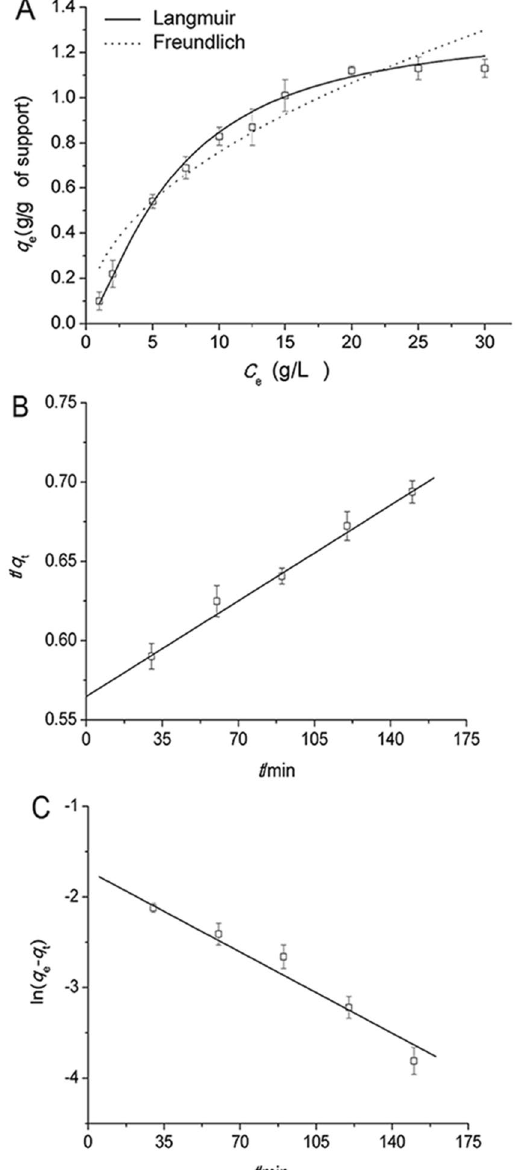
Figure 4. Langmuir and Freundlich isotherms ( A ), pseudo-second-order ( B ) and pseudo-first-order ( C ) adsorption kinetics of enzyme adsorped on graphene. Reaction condition: enzyme solution (20 g/L) was dissolved by disodium hydrogen phosphate-citrate buffer (pH 7); graphene nanoparticles mass (20 mg) was added in 4 mL of enzyme solution and the mixture was stirred at 120 rpm in an incubator shaker for 3 h, reaction temperatures was 50